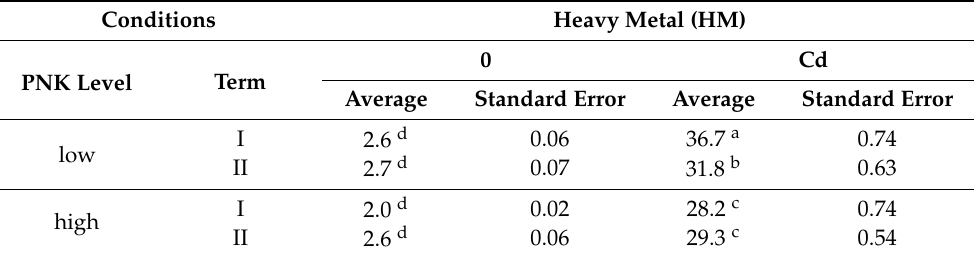
Table 2. The content of cadmium in Hydrocharis morsus-ranae ( µ g Cd · g − 1 d.w.) in the three tested growing seasons.